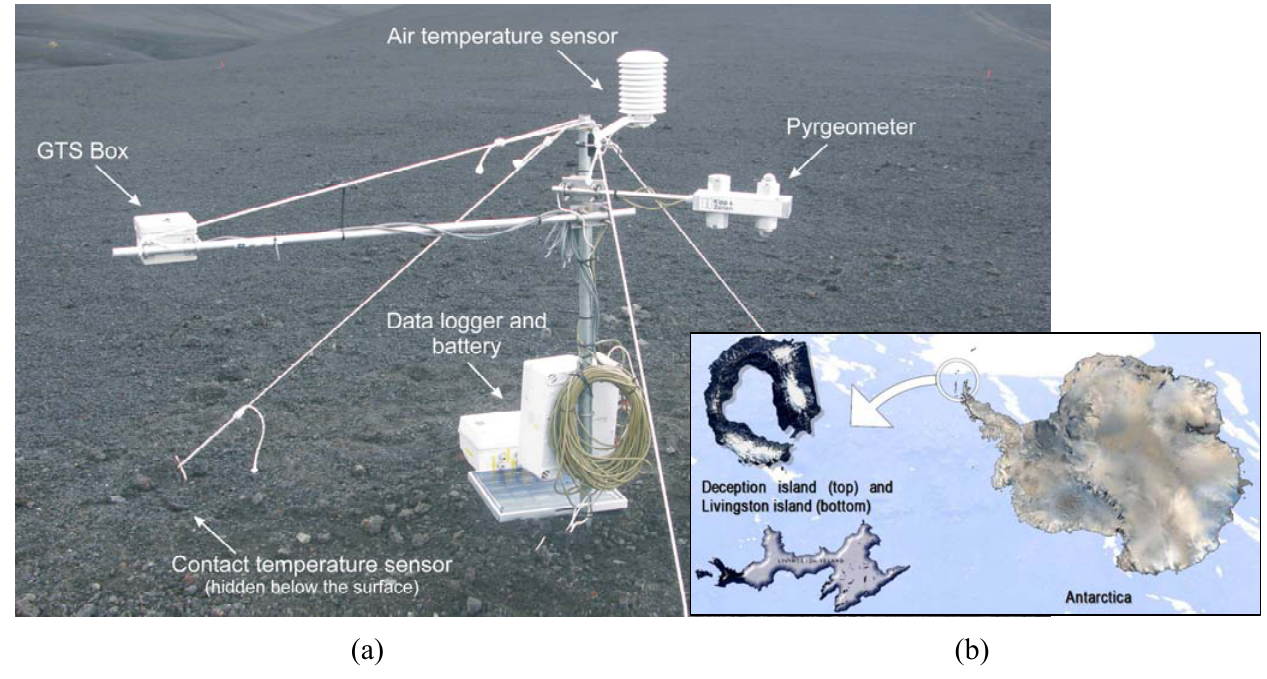
Figure 8. (a) Deployment of the REMS GTS: field test at Antarctica; (b) Location of the Spanish Antarctic Station on Deception